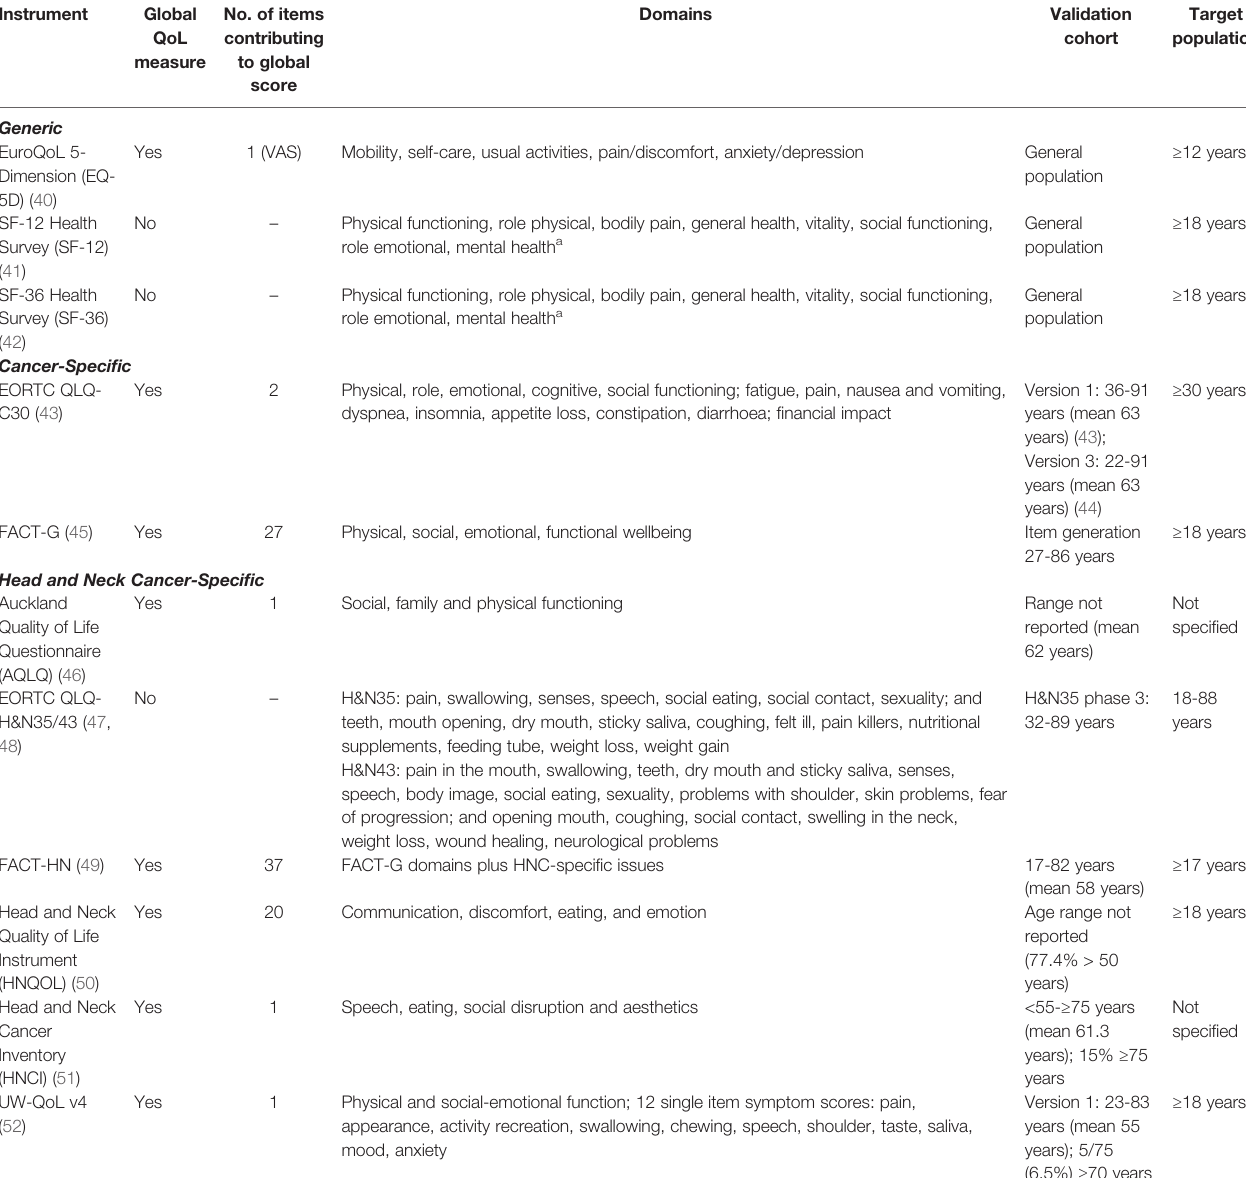
TABLE 6 | Health-related quality of life instruments often used in HNC studies.